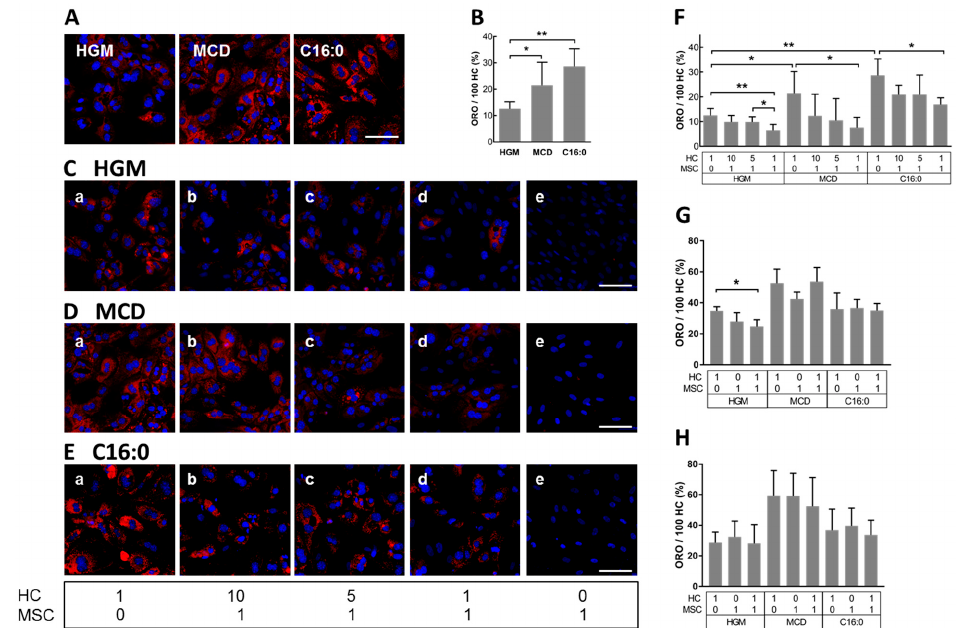
Figure 4. Induction of lipid droplet formation in cultured hepatocytes (HCs) by steatosis-inducing medium and reversal by MSCs in co-culture. Primary HCs were either cultured in HGM medium or treated with steatosis-inducing MCD medium or HGM supplemented with 0.5 mM palmitic acid (C16:0) for 3 days. ( A ) Visualization of hepatocyte lipids with Oil red O (red) and ( B ) quantification. HCs cultured ( a ) alone or together with MSCs at ratios of HCs to MSCs of ( b ) 10:1, ( c ) 5:1, ( d ) 1:1, or ( e ) 0:1 were grown for 3 days either in ( C ) HGM, or in ( D ) MCD, or in ( E ) HGM supplemented with C16:0.